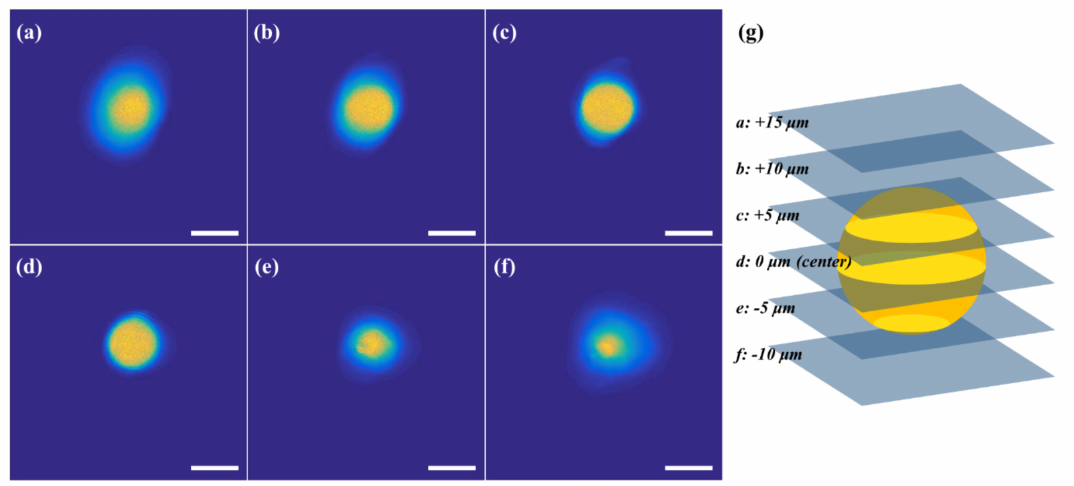
Figure 7. The images for a fluorescent microsphere at different depths from the center: ( a ) +15 µ m; ( b ) +10 µ m; ( c ) +5 µ m; ( d ) 0 µ m; ( e ) − 5 µ m; and ( f ) − 10 µ m. (scale bar: 10 µ m). ( g ) Illustration of a 3D image of a fluorescent